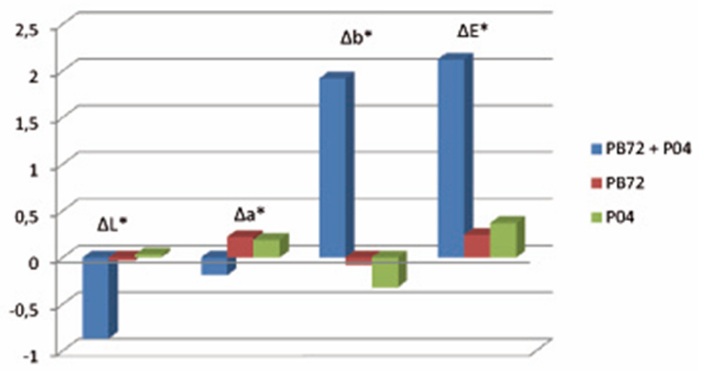
Figure 3. Color changes of stone samples after 168-h exposure in the solar box.